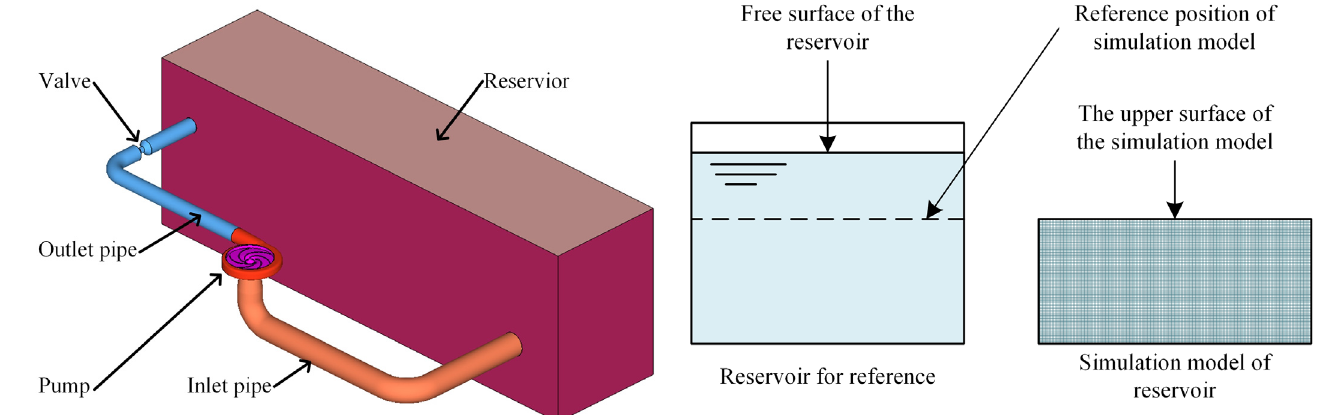
Fig. 3. The corresponding relationship between the simulation model and the actual structure of reservoir.